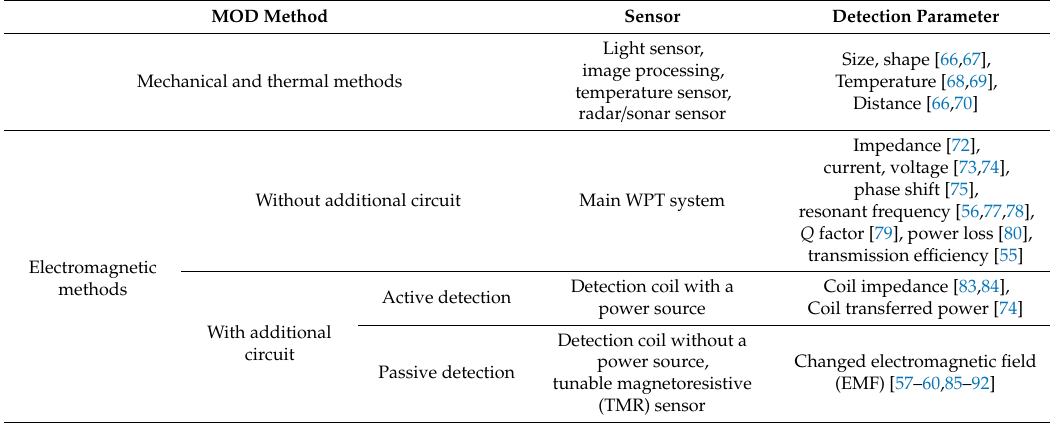
Table 1. Metal object detection (MOD)